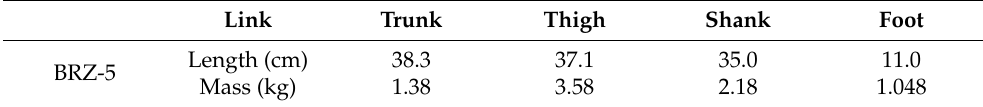
Figure 8. Kinematic model for BRZ-5. Table 3. Basic physical parameters of BRZ-5.